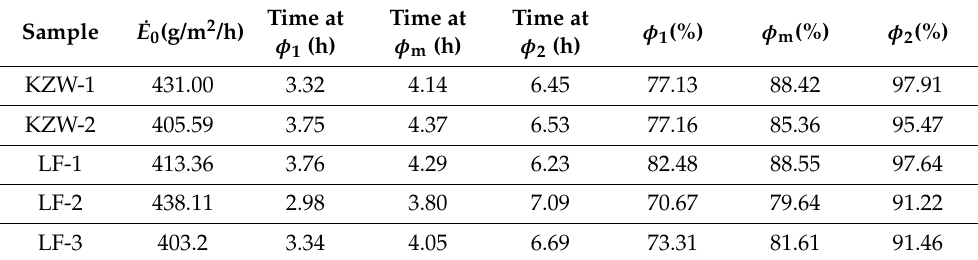
Table 4. Drying parameters of different bitumen emulsions.